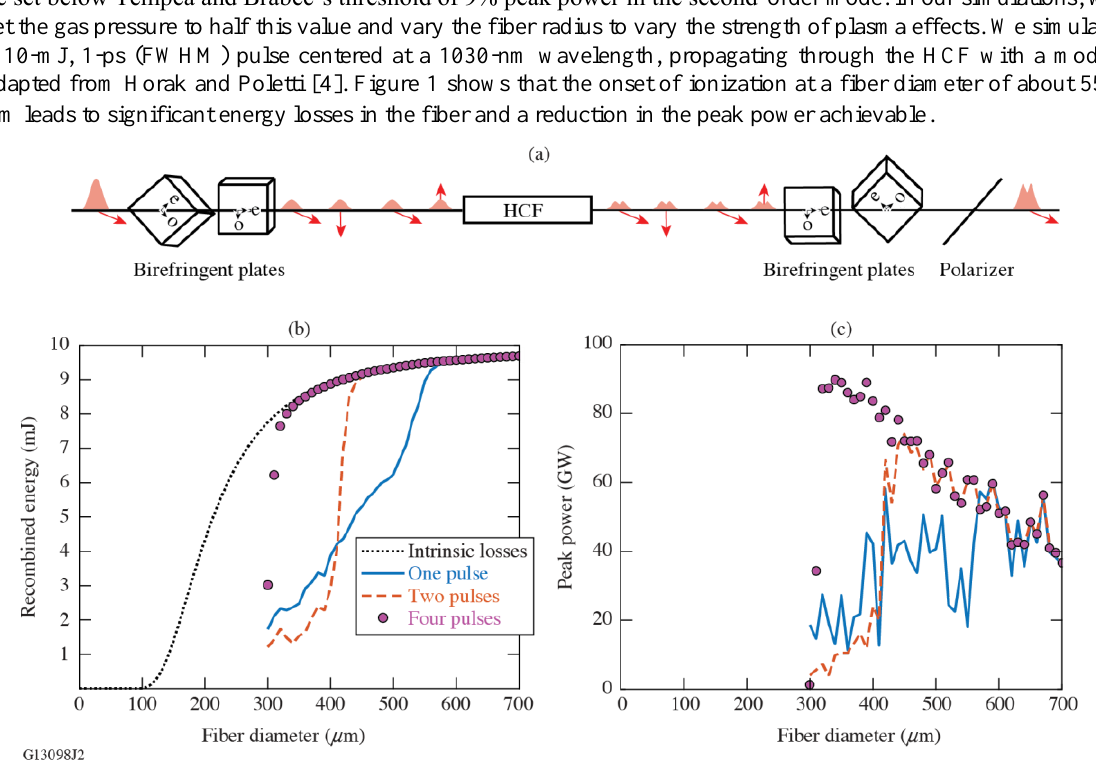
Fig. 1 (a) Schematic of DPNLC. (b) Simulated output energy after HCF and divided pulse recombination stages for a range of fiber diameters. Onset of ionization is clearly visible around 550  m, 400  m, and 300  m for one, two, and four pulses,